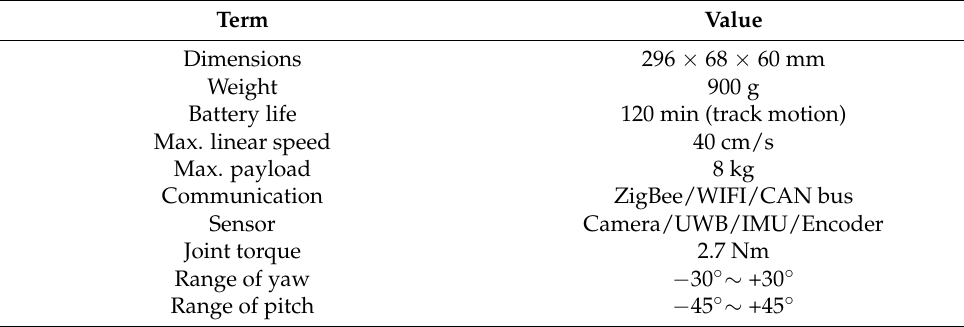
Table 1. A summary table of the parameters of SMMRob